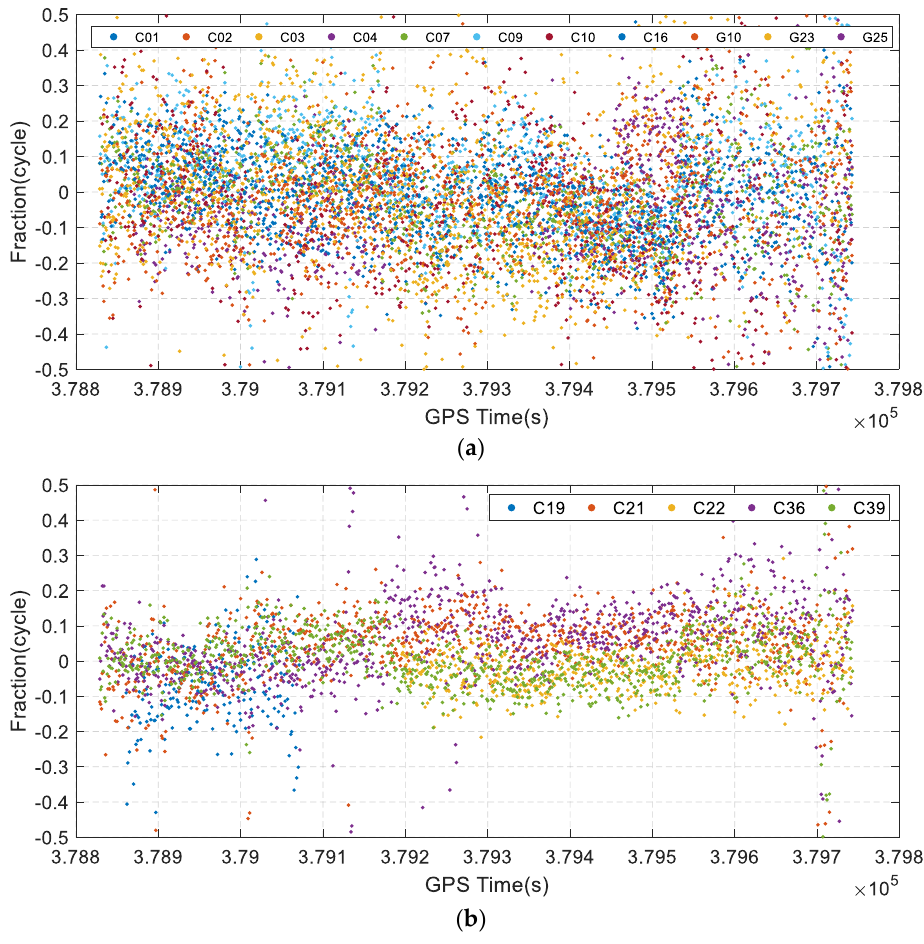
Figure 8. The WL ambiguity fractions of the GPS/BDS-2 and BDS-3: ( a ) GPS/BDS-2; ( b ) BDS-3. Table 5. Mean and STD values for WL ambiguity fractions of GPS/BDS-2, BDS-3, and all.